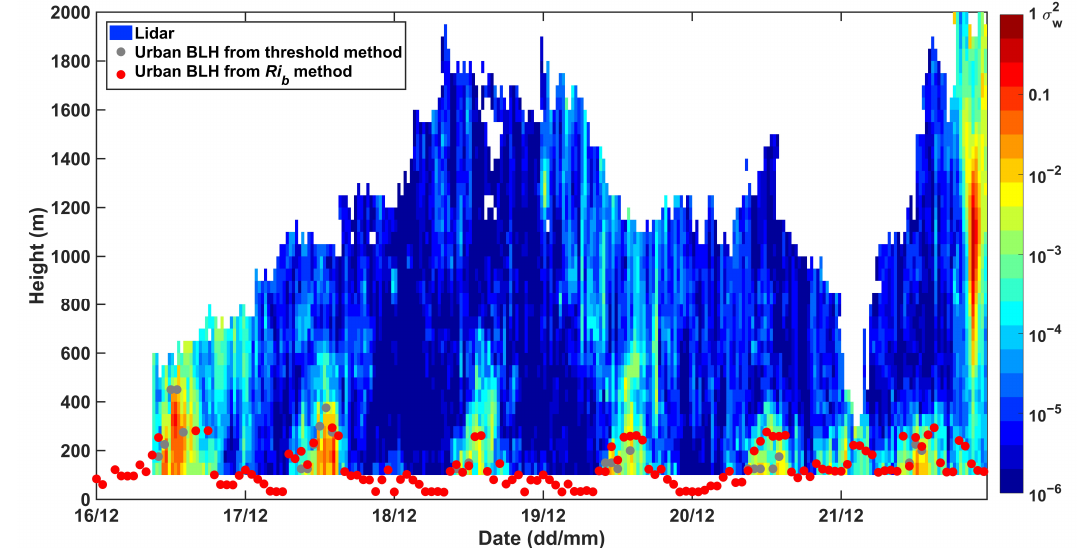
Figure 3. Velocity variance, σ 2 w (m 2 s − 2 ), calculated from the Doppler wind lidar data. Derived boundary layer depths, based on the threshold method (grey dots) and Ri b method (red dots). It should be noted that the blank part of the σ 2 w can be attributed to a technical failure on 16 December, and the di ff erent range spans on di ff erent days may mainly depending on the aerosol